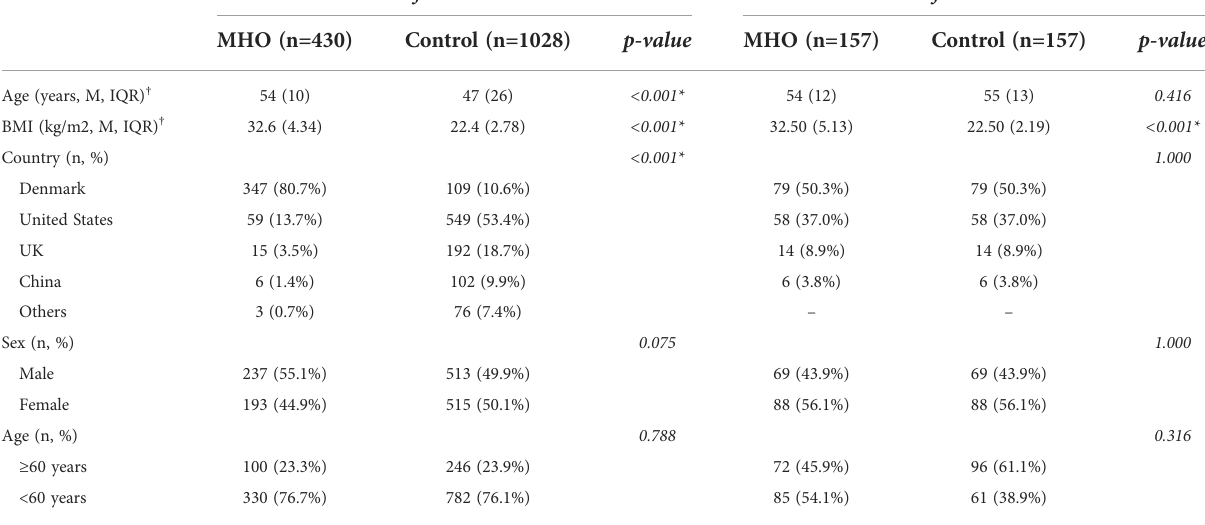
TABLE 1 Baseline characteristics of patients in the GMrepo database.